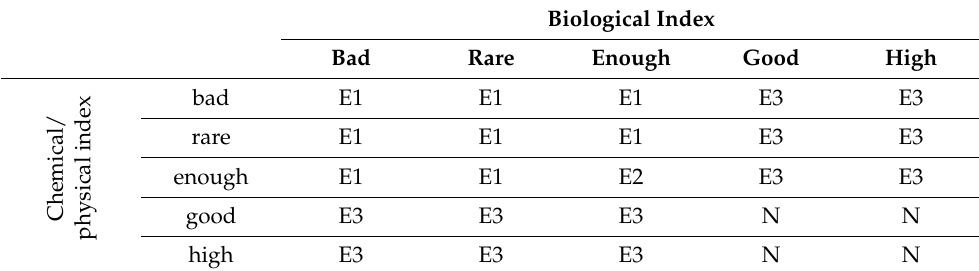
Table 4. Scheme for the identification of the trophy